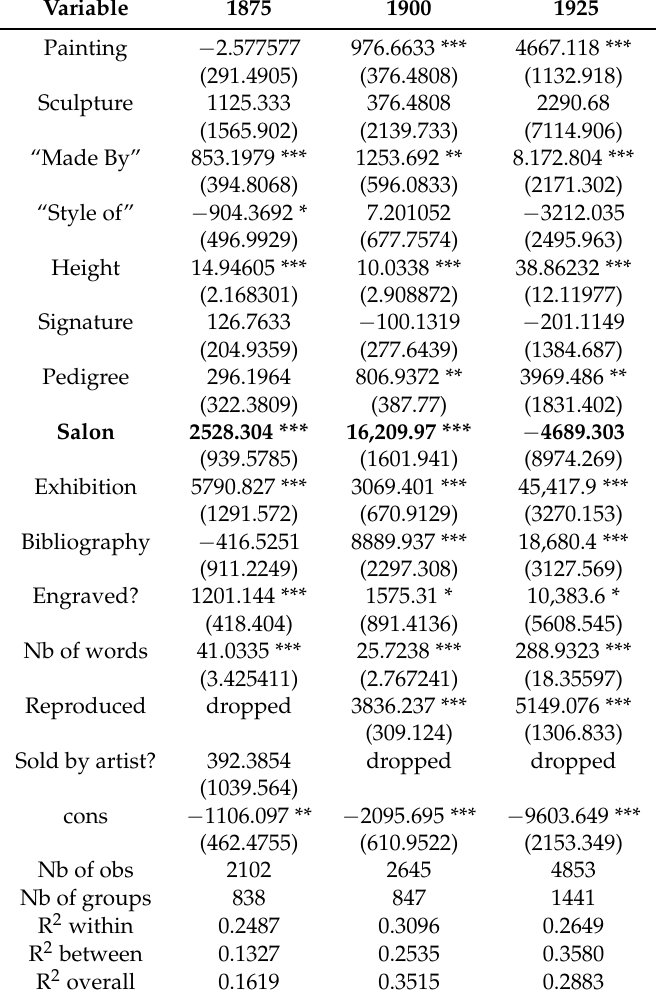
Table A1. Results of the hedonic regression, with a fixed “artist” effect, conducted on Parisian auction sales of paintings, drawings and sculptures, in 1875, 1900 and 1925. The explained variable is the hammer price (in current francs), excluding bought in prices (i.e., repurchases) and excluding